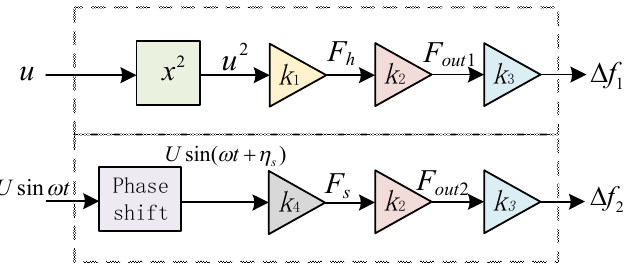
Figure 2. Relationship between air flow velocity and output signal of sensor.